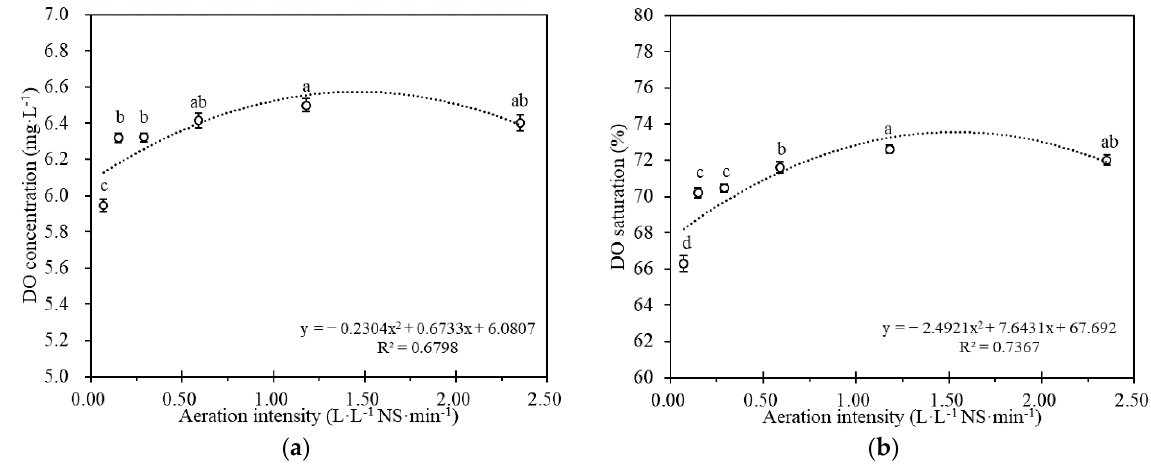
Figure 4. Dissolved oxygen (DO) concentration and saturation under different aeration intensities before cultivation in this study: ( a ) DO concentration; ( b ) DO saturation. A total of ten measurements were made at the same time (9:00–10:00 a.m.) on different days (water temperature = 21 °C ± 1 °C). Bars labeled with different letters indicate significant differences ( p ≤ 0.05); data are expressed as MSE ( n = 10).